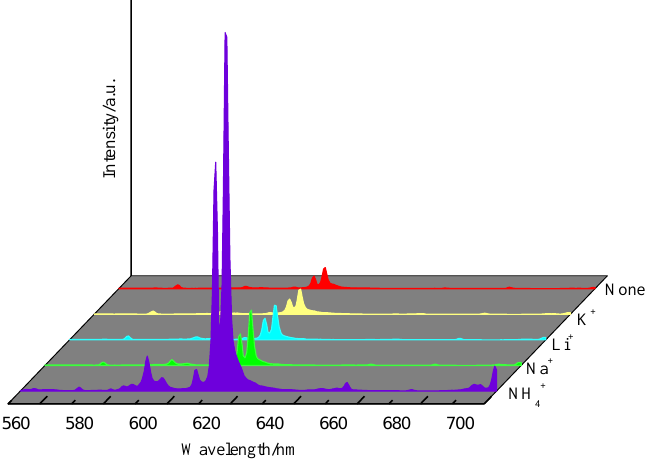
Figure 10. Emission spectra of SrMo 0.5 W 0.5 O 4 :Eu 3+ with different charge compensators.